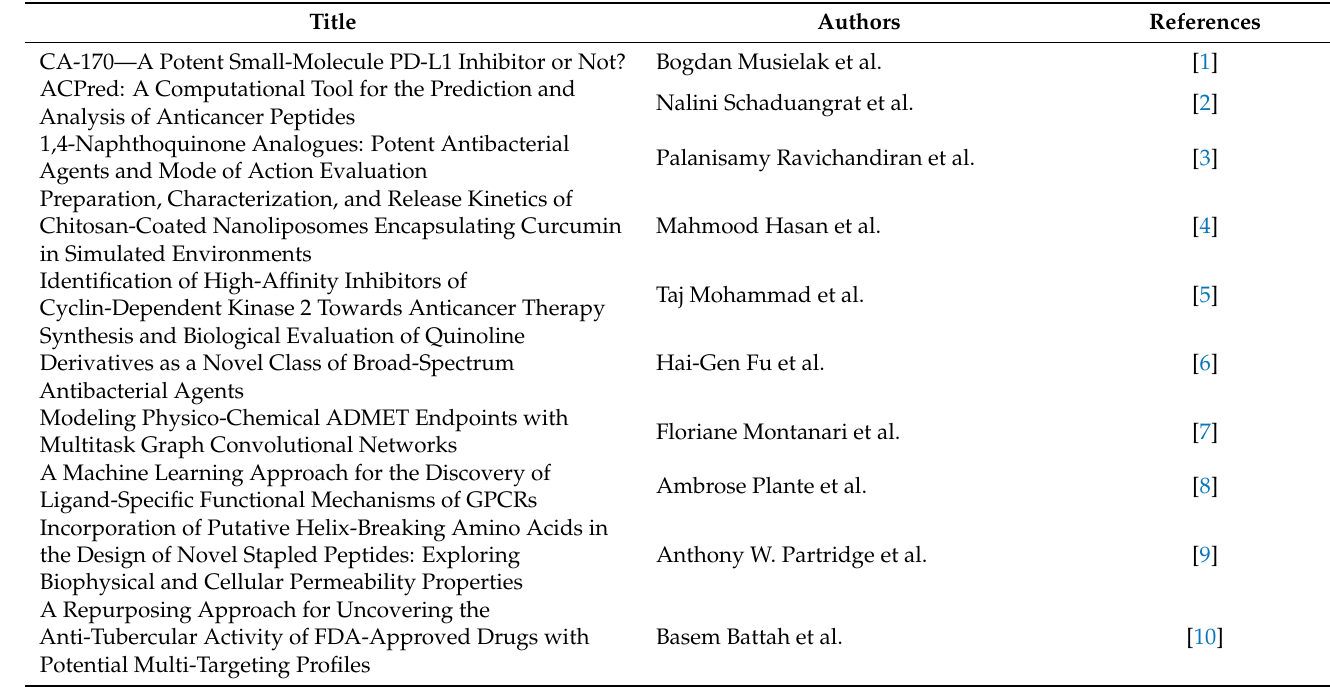
Table 1. The top 10 articles of 2019 in the Medicinal Chemistry section of Molecules.